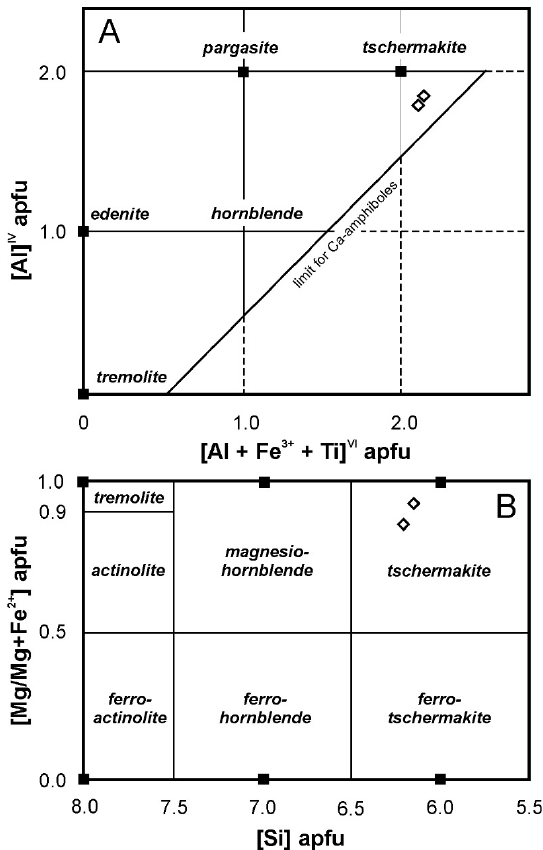
Figure 11. ( A ) Plot of Al IV versus Al VI +Fe 3+ +Ti [38] for amphibole from ˇCamovce (open diamonds) with projections of ideal endmembers (solid squares); ( B ) Classification diagram of calcic amphi- boles [39] with projections of data from ˇCamovce (open diamonds) and ideal endmembers (black squares).